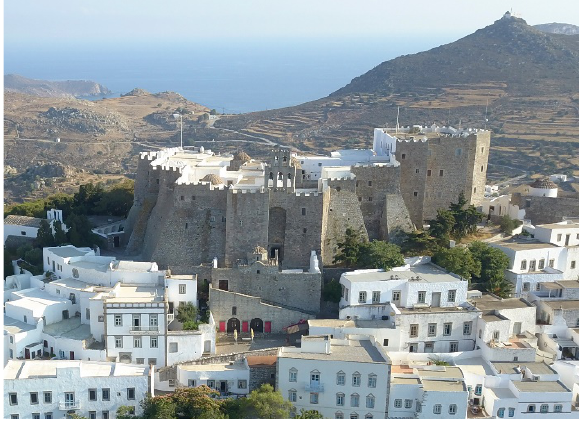
Figure 2. Monastery of Saint John the Theologian.